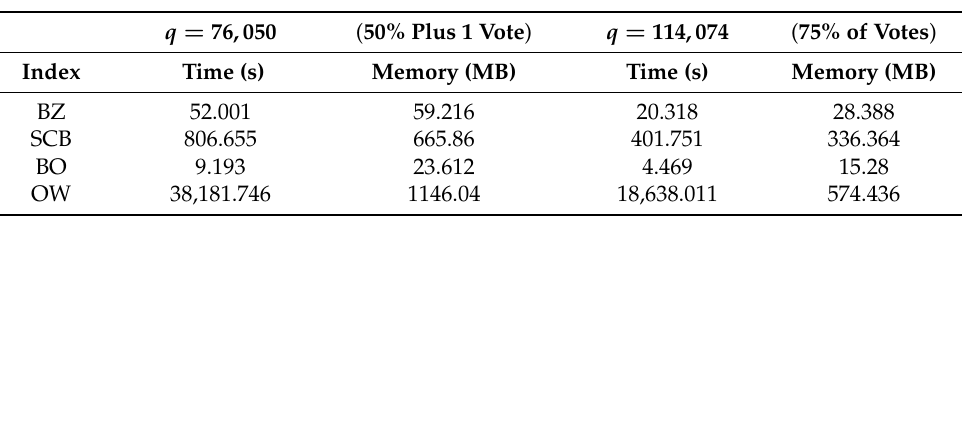
Table 2. Computing times and memory requirements for an example with 3034 players, ˜ w = 152,098, 60 precoalitions, a maximum coalition size of 78 and an average coalition size of